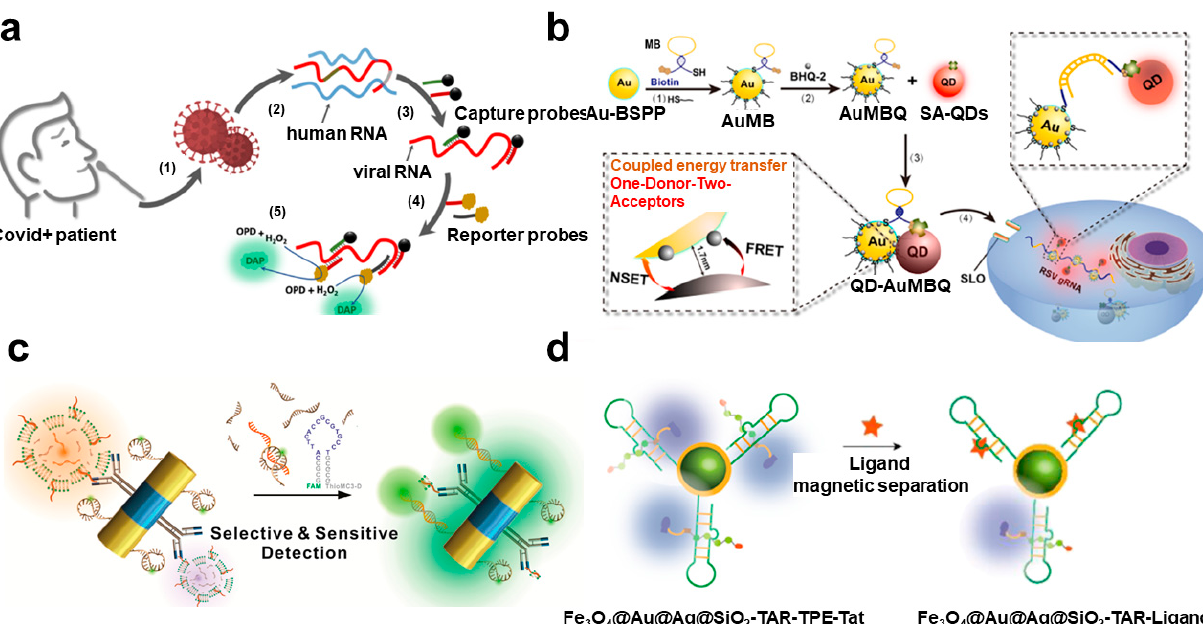
Figure 3. Viral RNA-target fluorescence biosensors using plasmonic nanomaterials: ( a ) Schematic